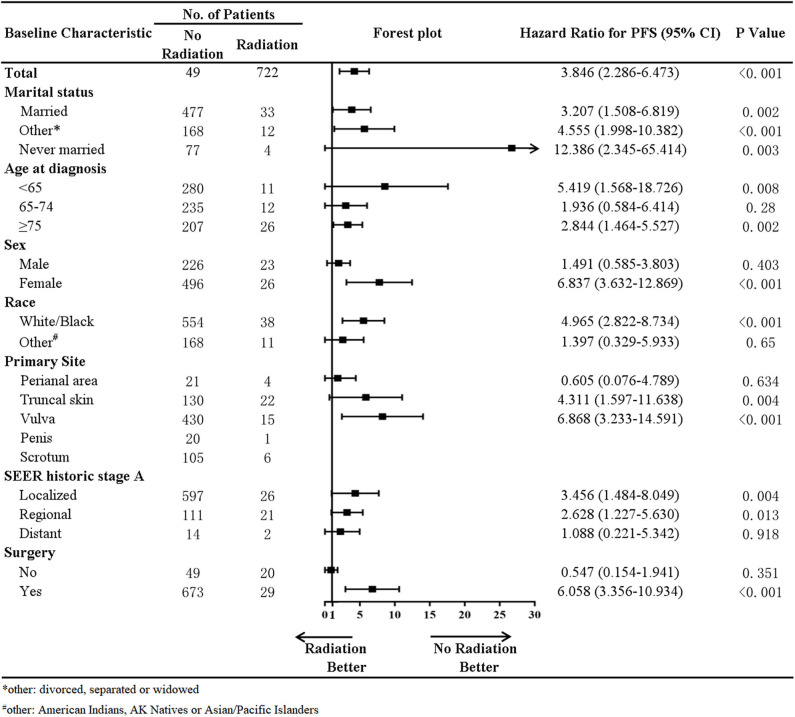
Forest plot of stratified analysis in radiation therapy.